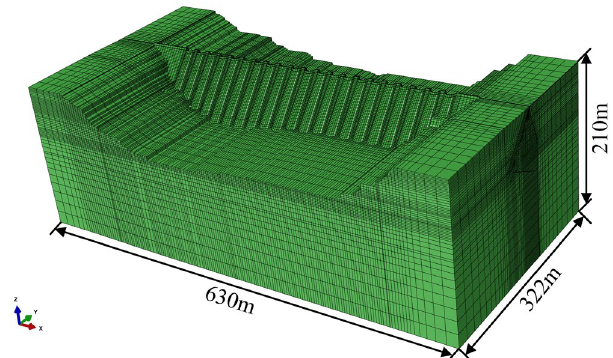
Figure 19. Numerical model of Foziling dam.